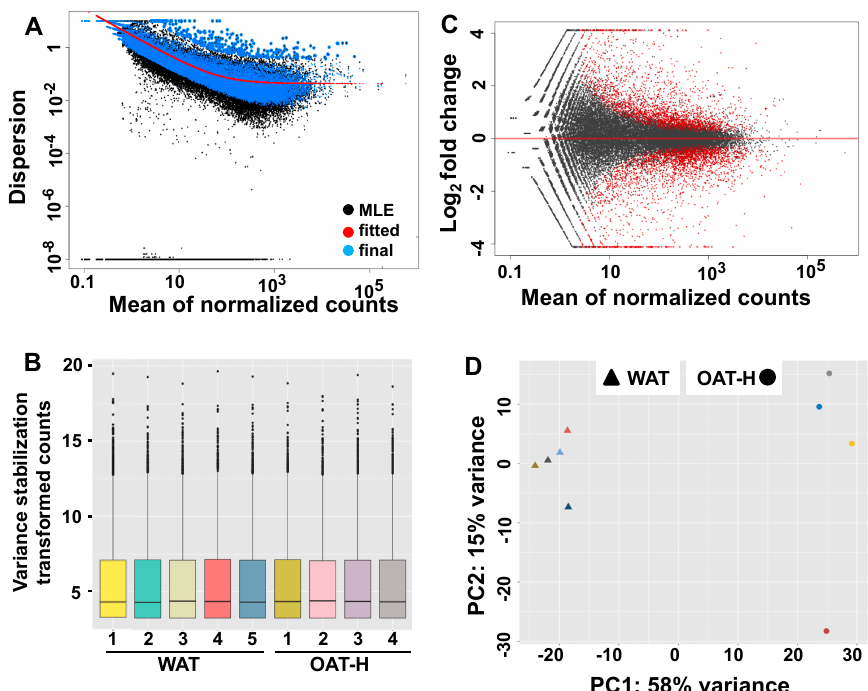
Figure 4. Transcriptional profiles of OAT comparing WAT. Di ff erential gene expression (DGE) analysis was performed using a DESeq2 model generated from ex vivo female samples of OAT-H ( n = 4) and WAT ( n = 5) (R / Bioconductor DESeq2 package). ( A ) Shrinkage estimation of dispersion plots provided a visual means of examining dispersion estimates of genomic features relative to average expression strength [26]. Black points represent per gene gene-wise maximum likelihood estimates (MLE). The red curve represents the overall trend of the dispersion to mean dependence. Blue points represent gene-wise estimates following shrinkage towards the mean (correction for noise). Black points circled in blue are dispersion outliers that are not shrunk towards the DESeq2 fitted model. ( B ) Sample level box plots provided a visual means of comparing the distributions of counts between samples, and shown lower, median and upper quantiles and counts for outlying features. ( C ) MvA plot shows the log2fold changes of OAT-H vs. WAT attributable to a given variable of the mean of normalized counts for all samples. Red points indicate a variable with an FDR- p -value < 0.1, and points falling outside of the plotting area are depicted as open triangles pointing either up or down. ( D ) A PCA plot was summarized at the sample-level following the exclusion of non-informative features (total counts across all samples < 1) for the top 500 genes in terms of highest variance (Table